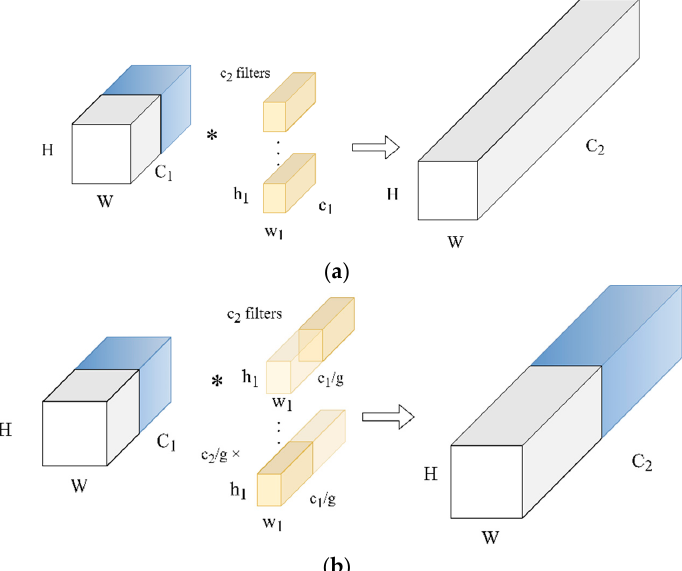
Figure 5. Standard 2D convolution is shown in ( a ) and group convolution is shown in ( b ).